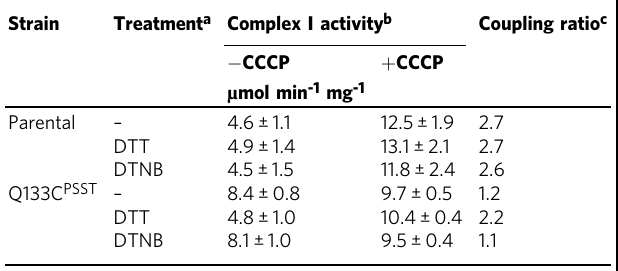
Table 2 Activities of puri fi ed complex I reconstituted into proteoliposomes